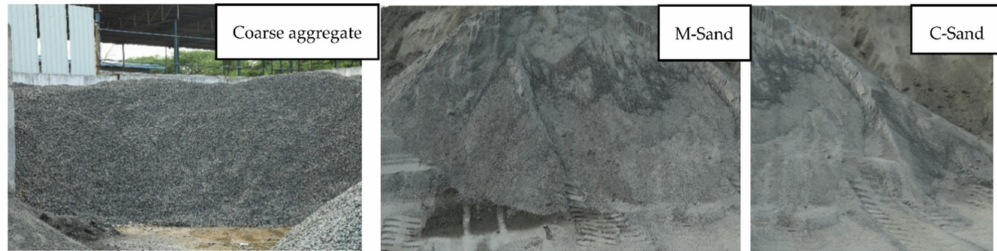
Figure 1. Storage of coarse aggregate and fine aggregate in the RMC